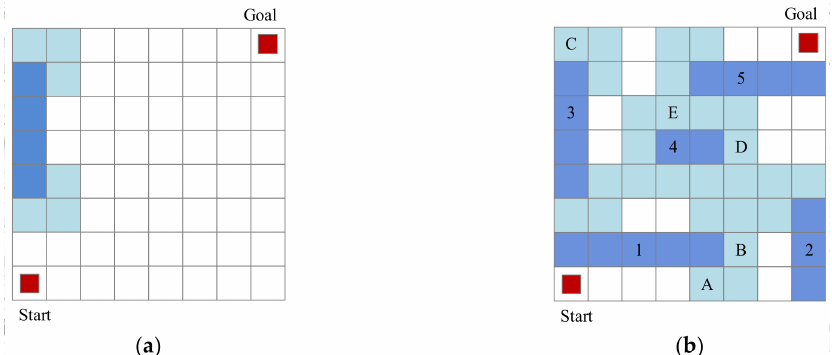
Figure 5. Selecting effective free cells. ( a ) Efficient free cells of one obstacle; ( b ) total efficient free cell.